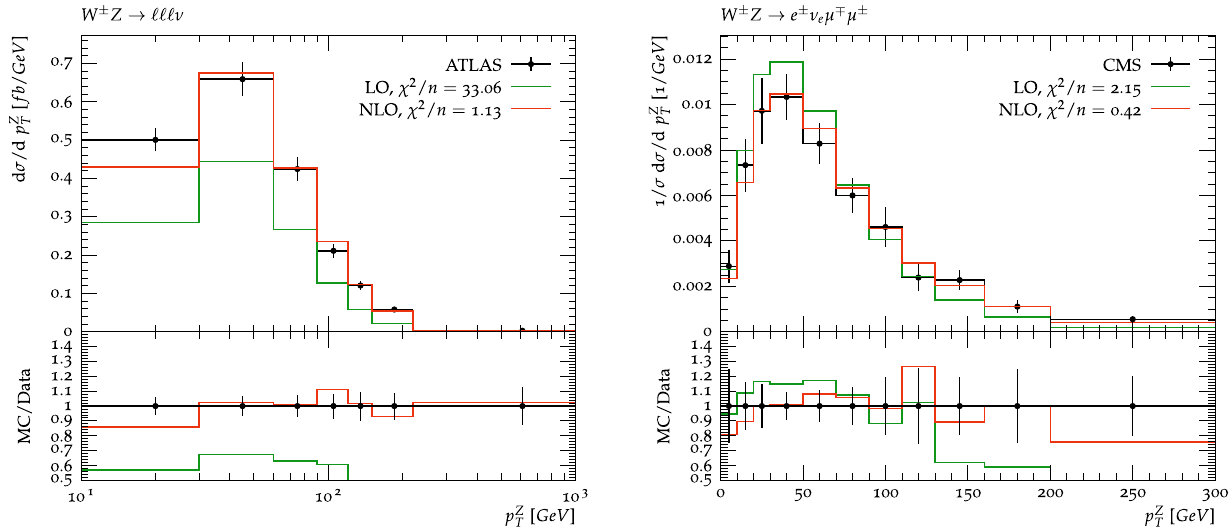
Fig. 10 The Z boson transverse momentum distribution, p Z , as measured in W ± Z production from ATLAS [57] and CMS [58] at 13 TeV based T on L = 36 fb − 1 . Note that while ATLAS provides an absolute distribution, the CMS one is instead normalised